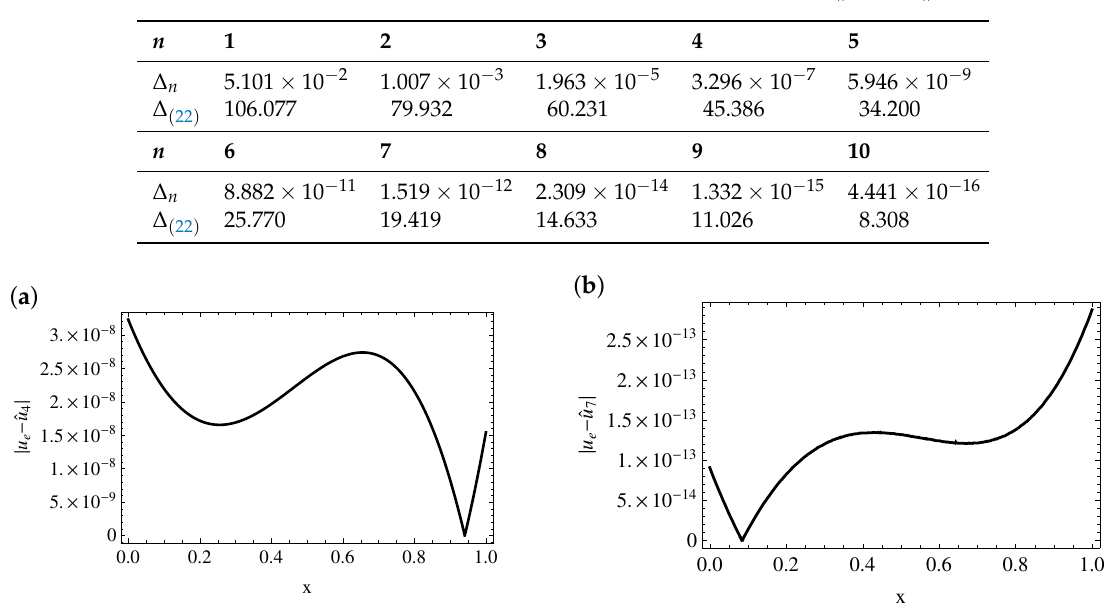
Figure 2. Distribution of error of the exact solution approximation for n = 4 ( a ) and n = 7 ( b